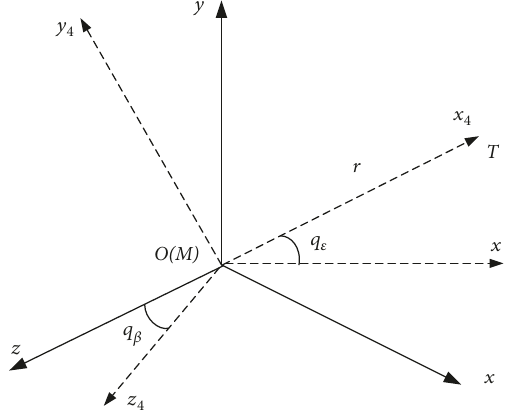
Figure 1: The relative relationship between the interceptor missile and its target in 3D